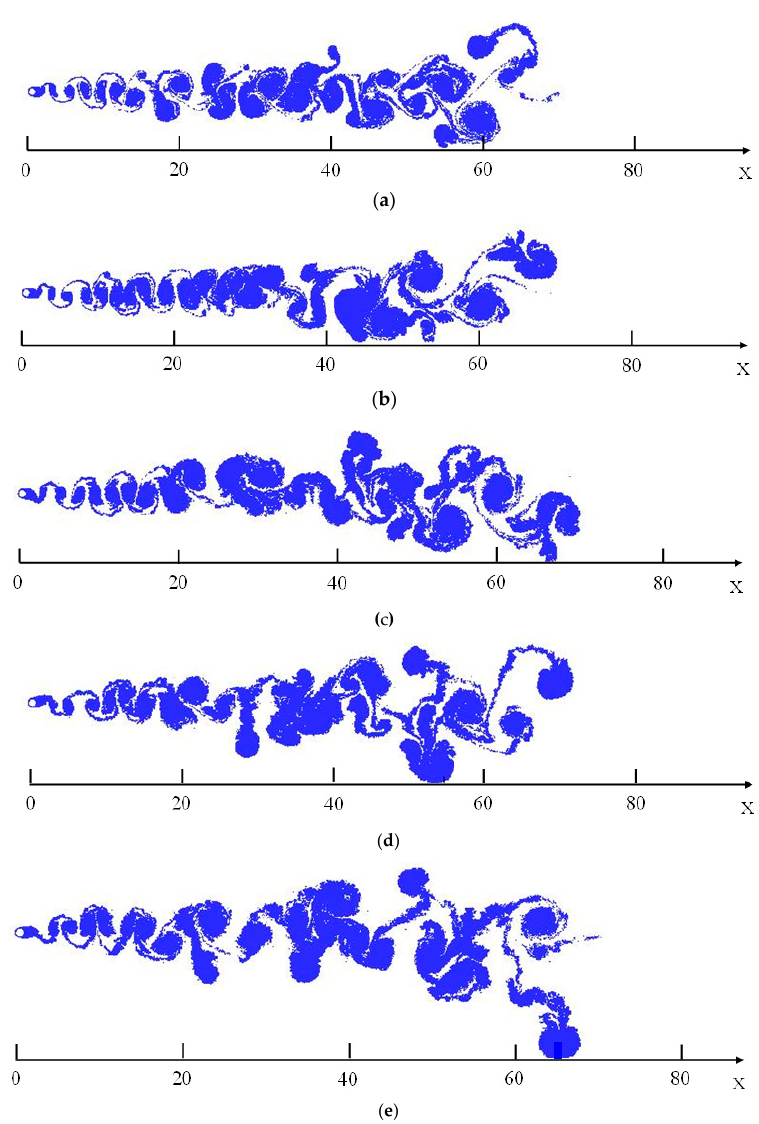
Figure 12. Final position of the viscous wake at t = 75 (Re = 1.0 × 10 5 ): ( a ) Smooth; ( b ) ε = 0.10%; ( c ) . ε = 0.20%; ( d ) ε = 0.45%; ( e ) ε =